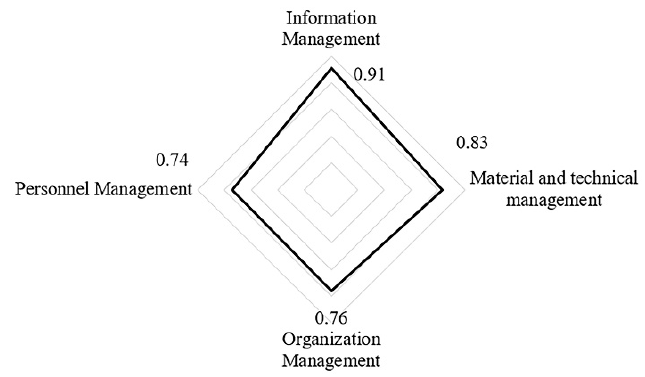
Figure 5. Validity of the four dimensions.